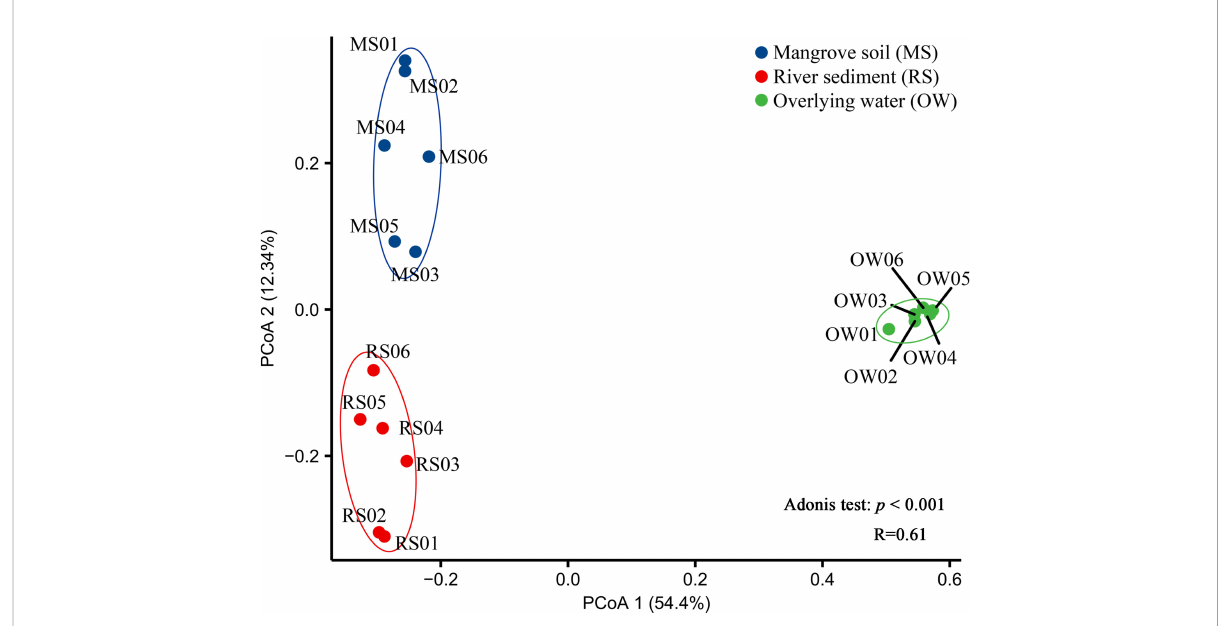
FIGURE 2 Principal Coordinate Analysis (PCoA) analysis of taxonomic composition of bacterial communities using Bray – Curtis dissimilarity based on the relative abundance of OTUs. Adonis test: p < 0.001, R